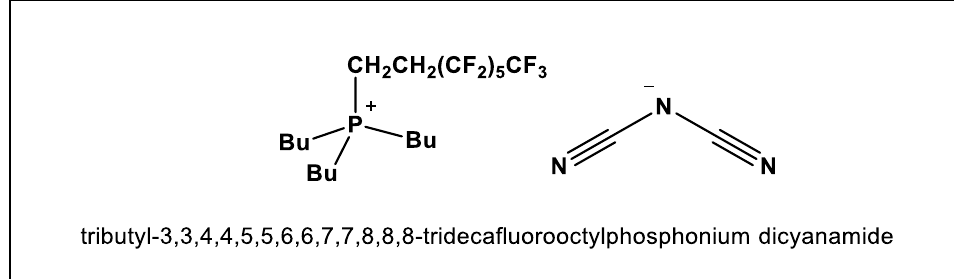
Figure 19. Chemical structure of the ionic liquid formed from a fluorinated phosphonium cation and a dicyanamide anion.